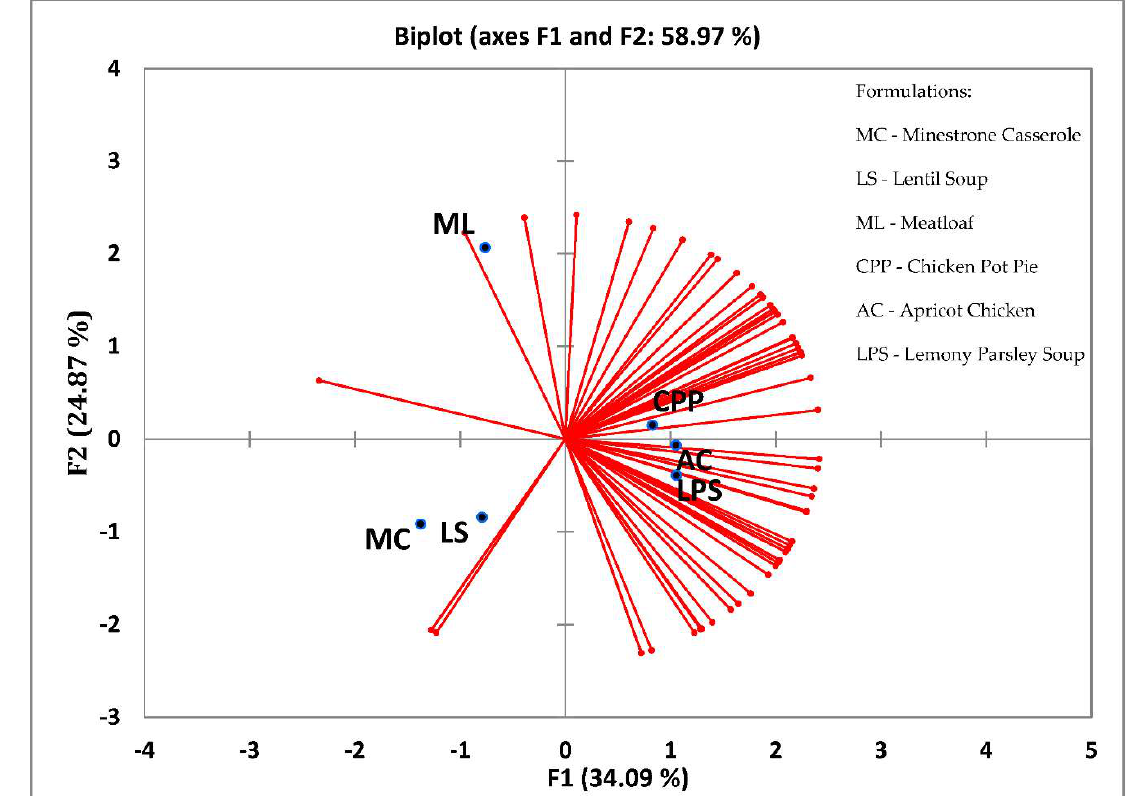
Figure 2. Consumer vector plot for overall acceptability.